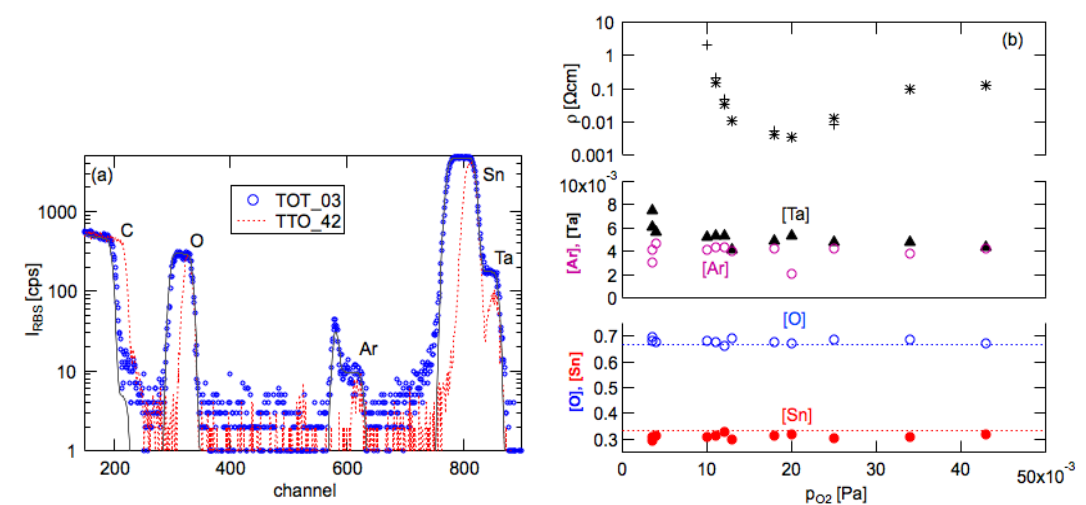
Figure 6. ( a ) Rutherford backscattering spectra of two SnO 2 :Ta films on a logarithmic intensity scale displaying the backscattering peaks / shoulders for the elements Ta, Sn, Ar, O and C (with decreasing energy, i.e., channel number). The two films were deposited at low- (TOT_03) and high- (TTO_42) oxygen partial pressures. The thin line is the simulated Rutherford backscattering spectrometry (RBS) curve of the film TOT_03. ( b ) Average chemical composition as a function of the reactive gas pressure in comparison to the resistivity of the films.